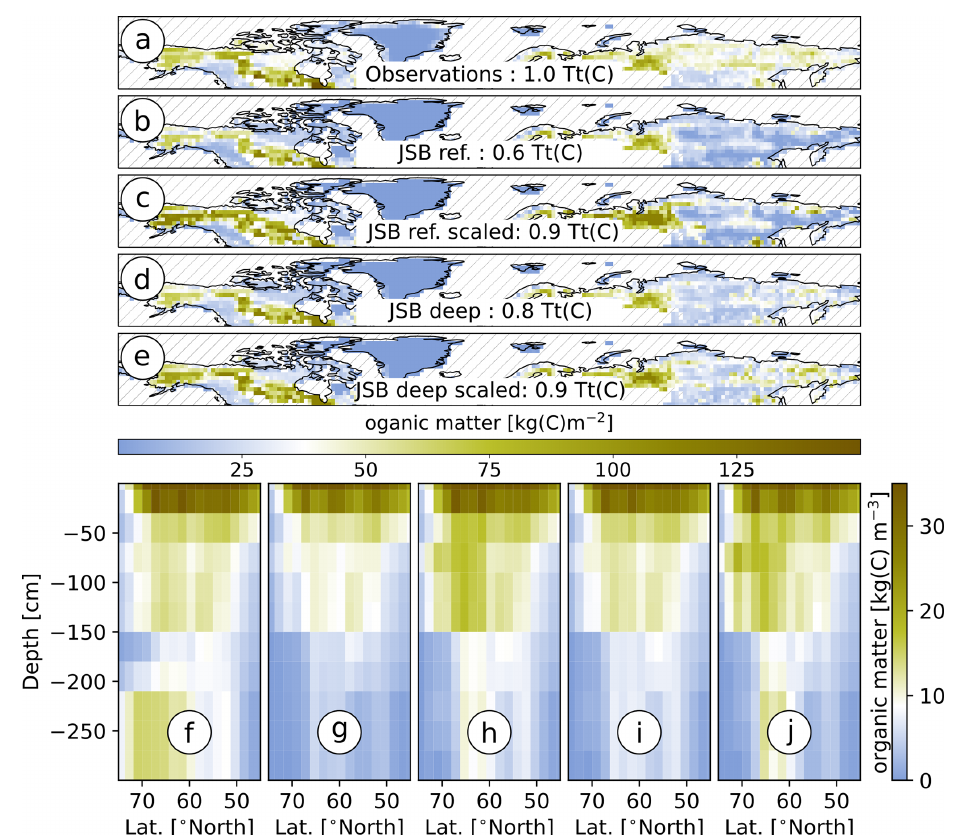
Figure 4. Initial soil carbon. (a) Spatial distribution of soil organic matter in permafrost regions based on WISE30sec data, above a depth of 2m and on NCSCDv2 data for depths between 2 and 3m. In regions in which NCSCDv2 is available – roughly those that, in reality, are affected by continuous, discontinuous and sporadic permafrost – the soils contain about 1015Gt organic carbon. (b) Same as (a) but only the organic matter that is located above the bedrock border assumed in the standard-model setup – roughly 636GtC. (c) Same as (b) but for upscaling those carbon pools that are located above the bedrock border to 858GtC. (d) Same as (b) but for a setup that assumes deeper soils – 797GtC. (e) Same as (c) but for a setup that assumes deeper soils – 931GtC. (f) Same as (a) but showing the vertical distribution (zonal average). (g) Same as (b) but showing the vertical distribution. (h) Same as (c) but showing the vertical distribution. (i) Same as (d) but showing the vertical distribution. (j) same as (e) but showing the vertical distribution. JSB: